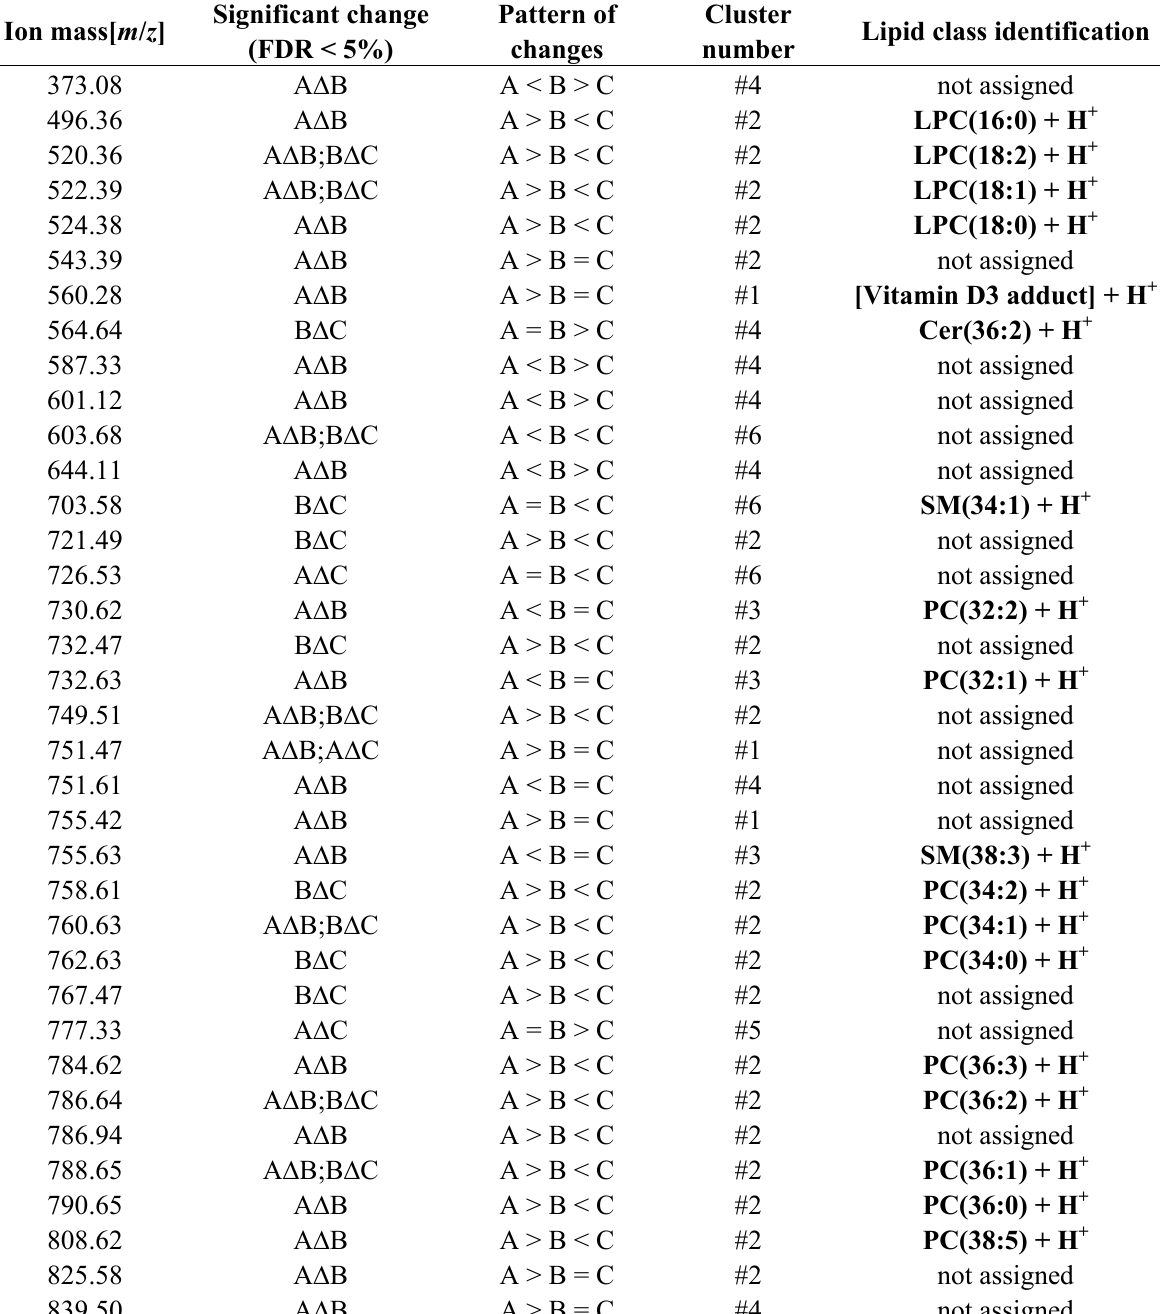
Table 1. Spectral components that changed abundances significantly between analyzed time points. Shown here is the registered m / z value, significant change in abundance, real pattern of changes, cluster number (hypothetical pattern of changes) and identification (lipid class and length of fatty acyl chains) of analyzed spectral components ( i.e. , lipid species); components of isotopic envelope were excluded from